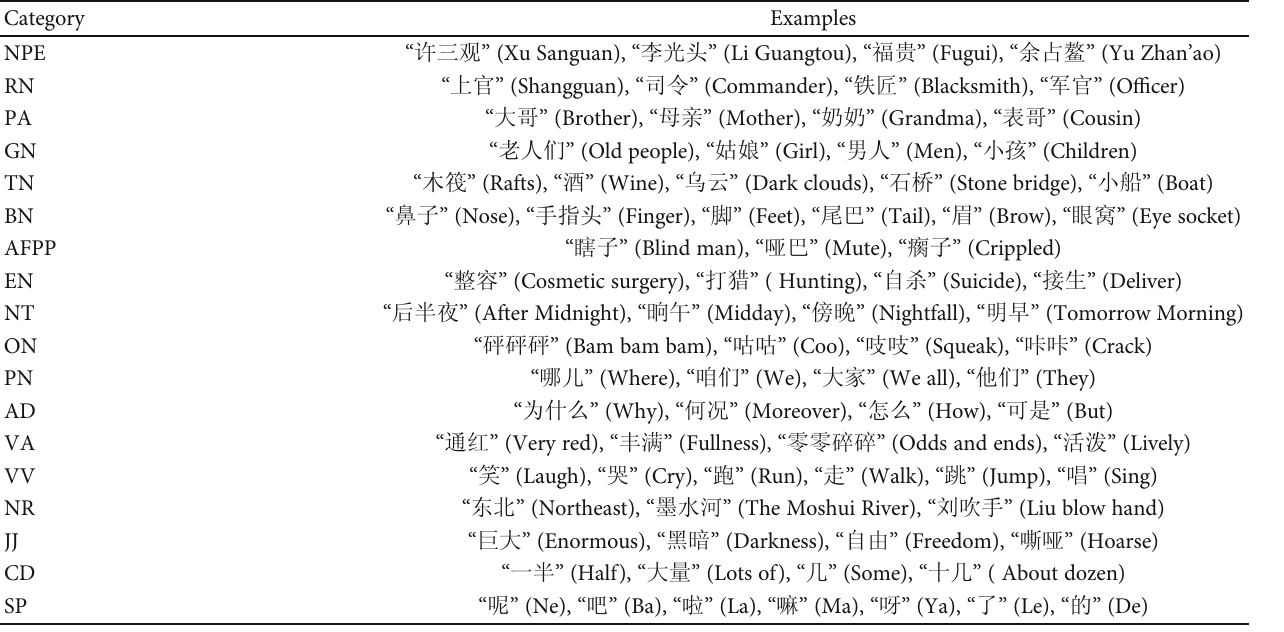
Table 5: Novel keyword list (part).